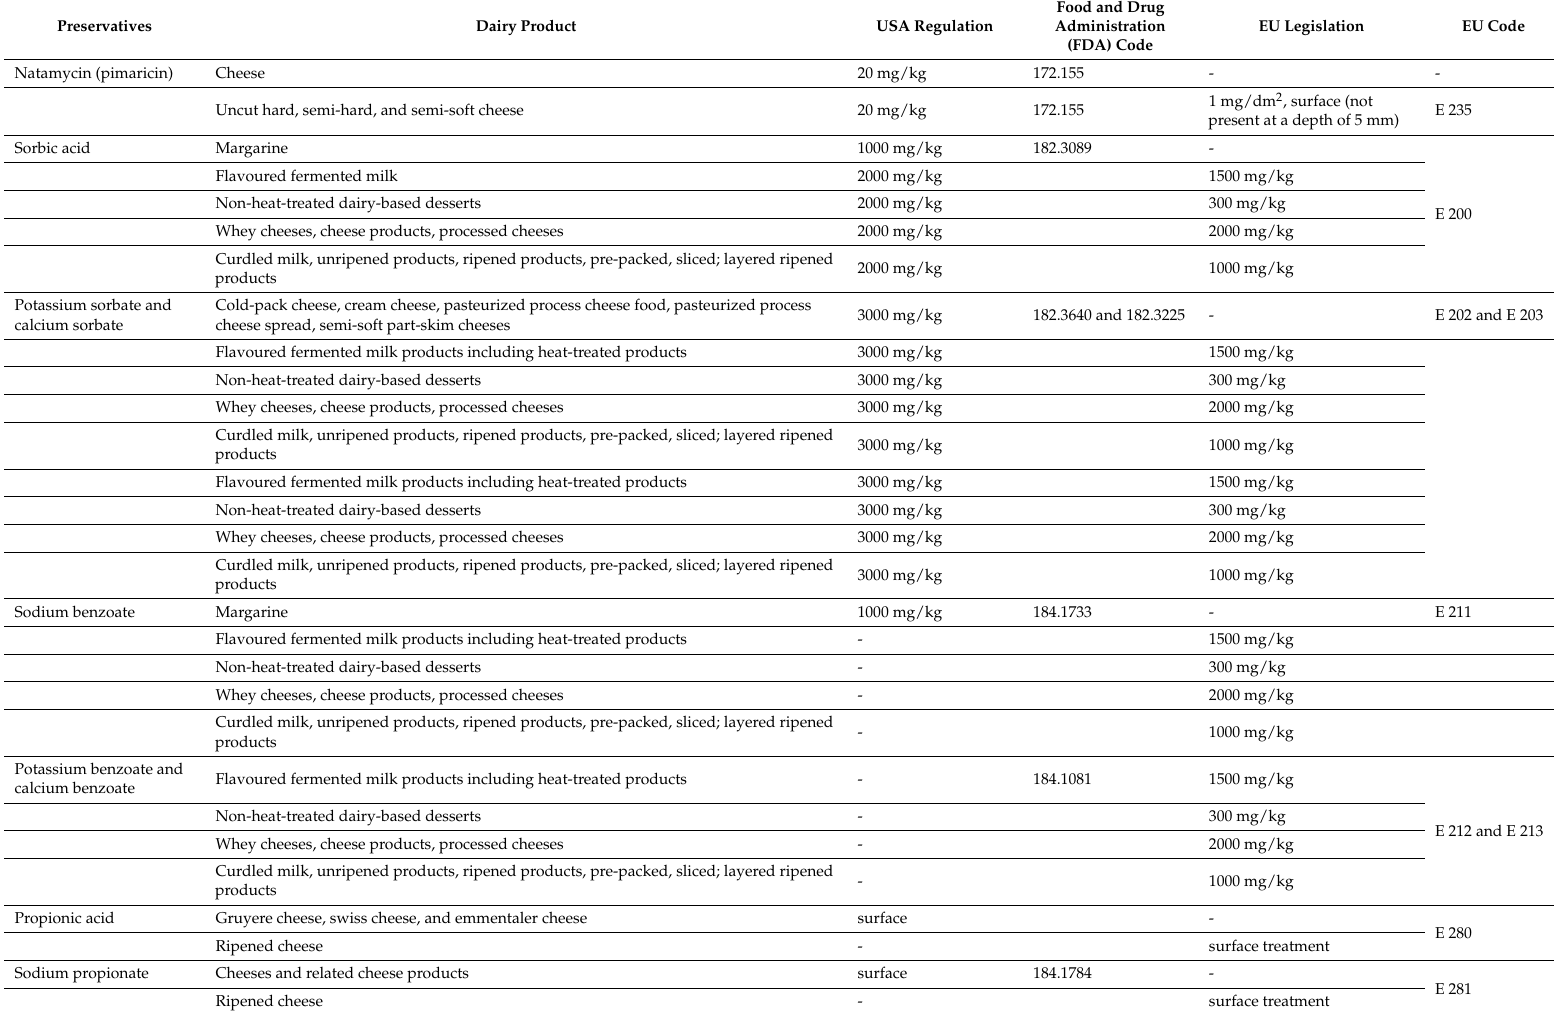
Table 3. List and regulations of chemical preservatives authorized in dairy products in the European Union (EU) [119] and the United States of America (USA) [120]. Preservatives